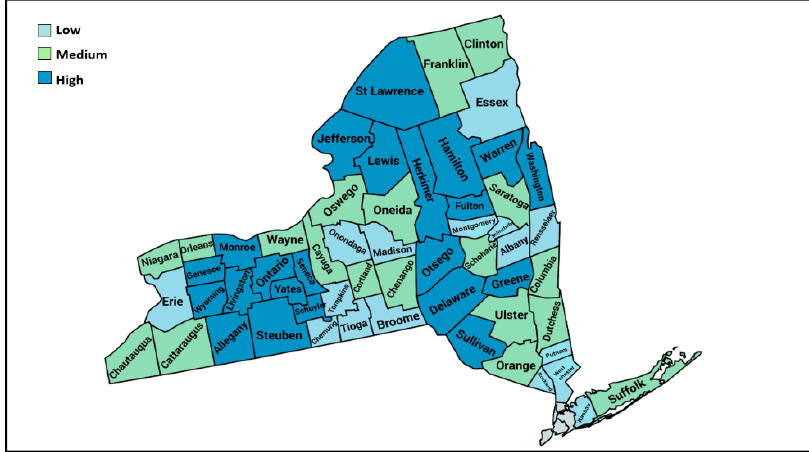
Figure 1. Classification of counties into low (light blue), medium (green) and high (dark blue) annual alcohol-related MV injury rates per 100,000 population.